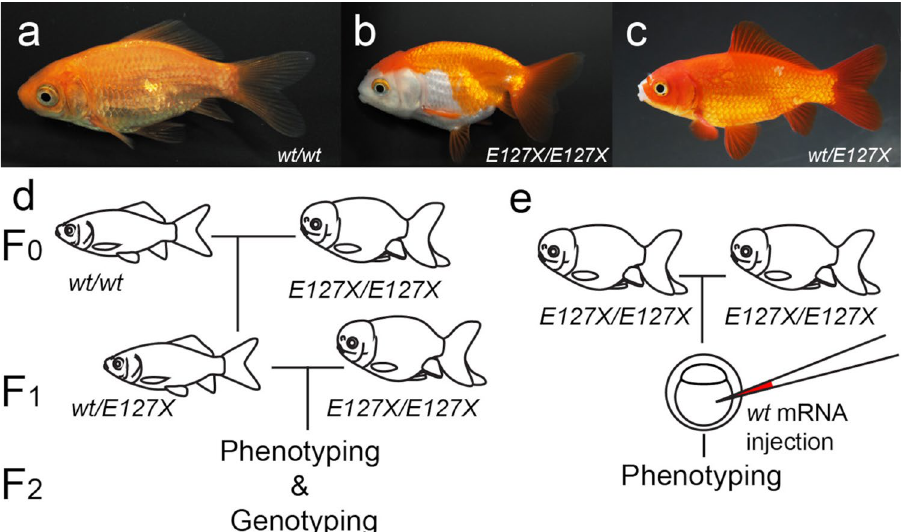
Figure 1. Schematic views of experimental procedures. Lateral views of the wild-type ( a ) and Ranchu strain ( b ) goldfish. ( c ) A lateral view of hybrid progeny of Ranchu and wild-type. ( d ) Schematic representation of backcross analysis. ( e ) Schematic representation of mRNA microinjection rescue experiment. The size of the individuals in ( a , b , and c ) are 5 cm, 6 cm and 6 cm approximately,